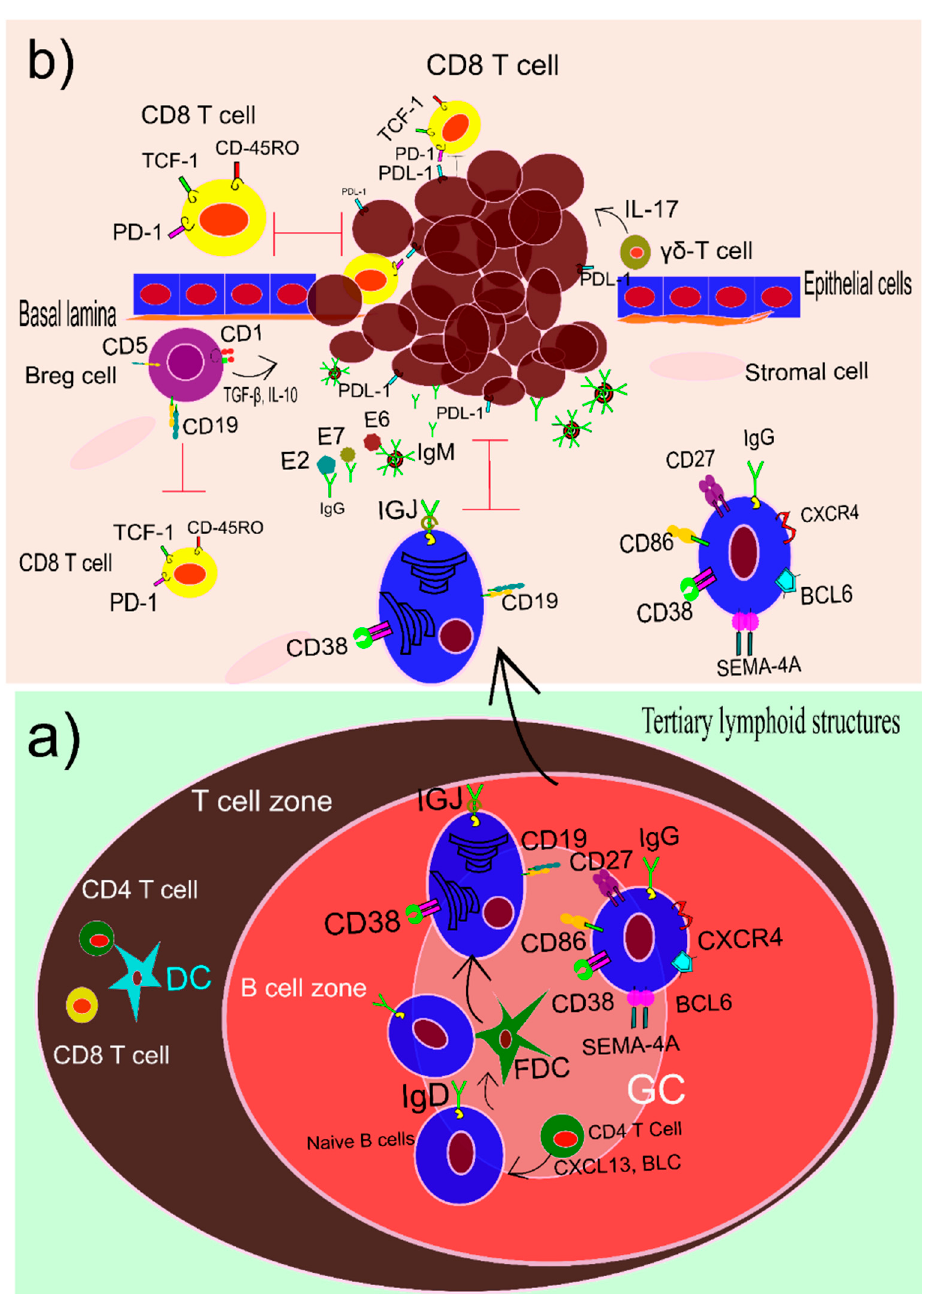
Figure 3. ( a ) The tertiary lymphatic structures (TLSs) appear in the HPV-related tumor tissues due to the chronic infection with HPV. These TLSs are the main player in the maturation of B cells and plasma cells. The cells produce a large number of antibodies against HPV antigens. ( b ) In the HPV-related tumor microenvironment mature B cells, plasma cells, and B regulatory cells (Breg) have a pivotal role. Plasma cells and B cells have a protective contribution and increase the overall survival of patients. In contrast, Breg cells are pro-tumor and support tumor metastasis. Both plasma and B cells secret monoclonal IgG and IgM antibodies against major antigenic proteins of HPV such as E6, E7, and E2. The Breg cells interfere with CD8 T cells and produce cytokines such as IL-10 and TGF- β that promote tumor evasion.